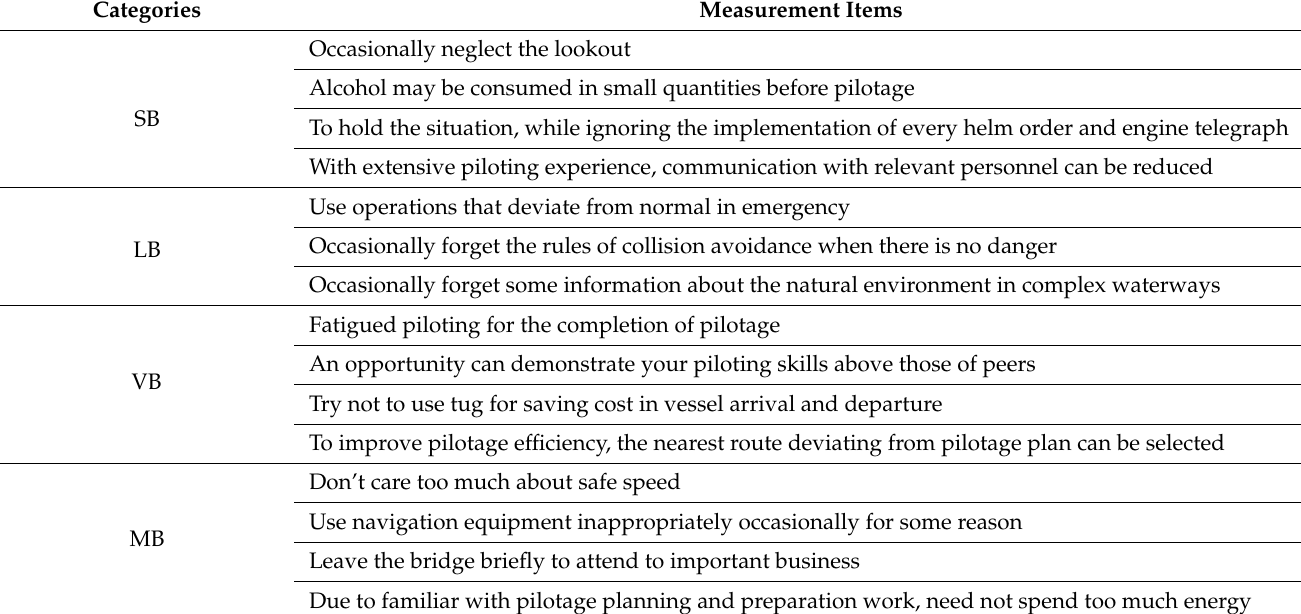
Table 1. Pilot unsafe behavior classification measurement scale.